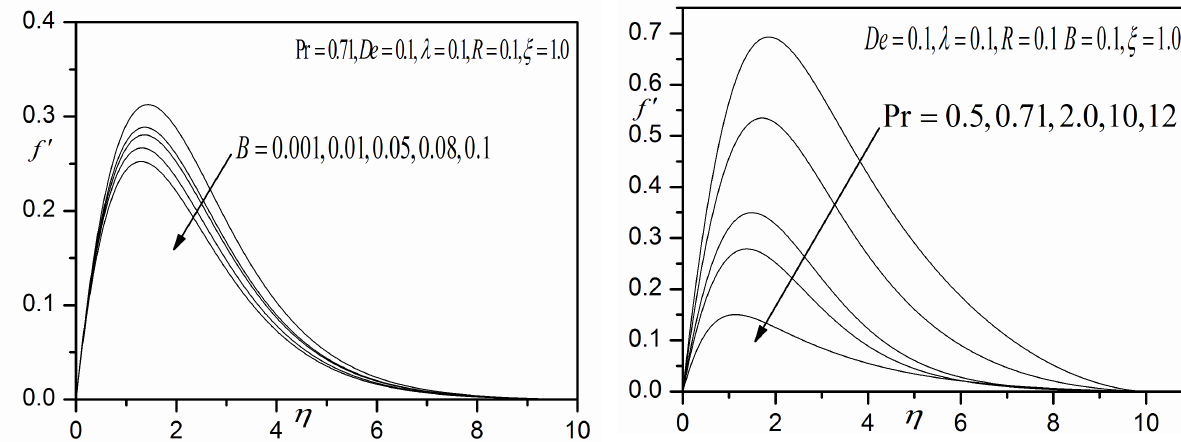
Fig. 14: Influence of Pr on the velocity.